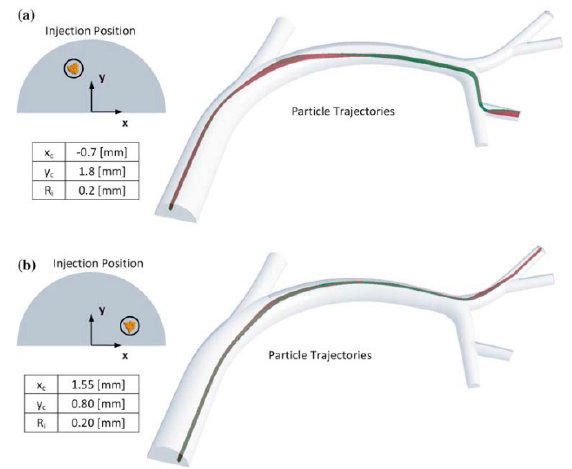
Figure 1. Computational fluid dynamic (CFD) simulation results: microsphere trajectories in the common hepatic artery (CHA) are dependent on release location [7].